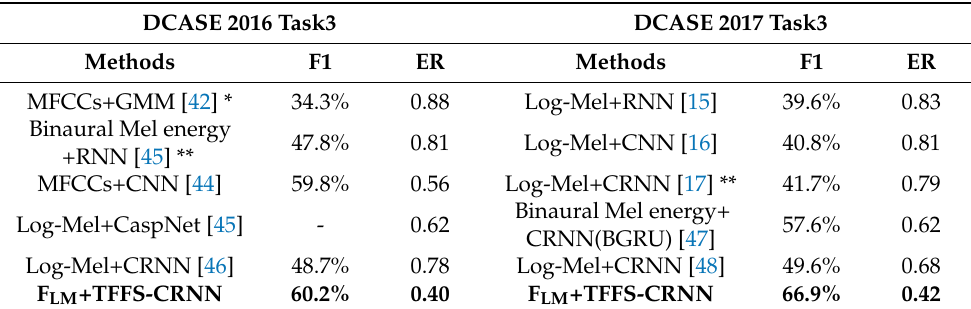
Table 6. The results of different methods.